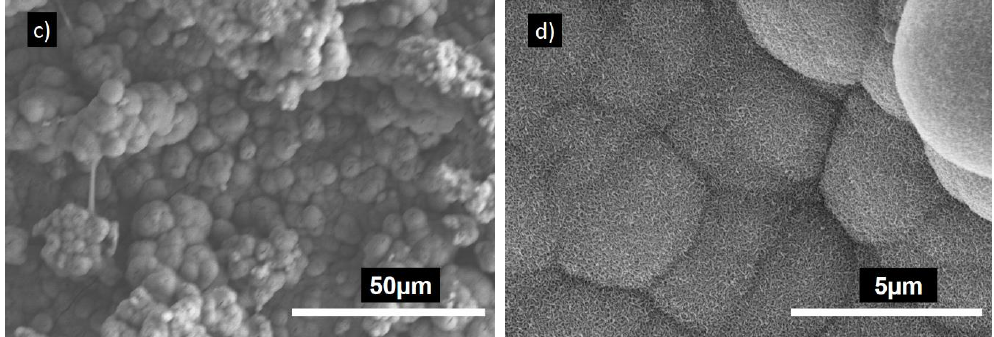
Figure 5. SEM images of ( a ) CPC-0 BT, ( b , d ) CPC-20 BT and ( c ) CPC-40 BT after 7 days immersion in 1.5 × simulated body fluid (SBF).